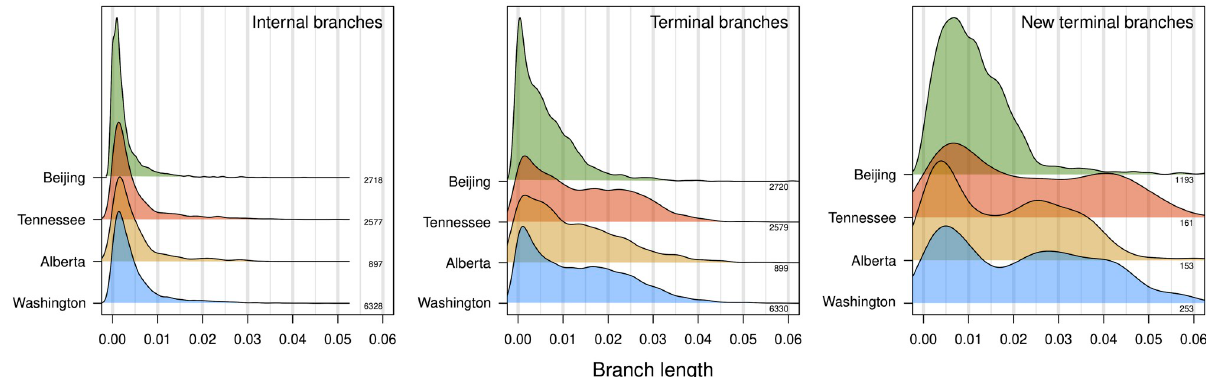
Fig 2. Distributions of branch lengths in HIV-1 pol phylogenies. Each density summarizes the distribution of branch lengths (measured in units of expected nucleotide substitutions per site) for different locations and types of branches, as indicated in the upper right corner of each plot. We used Gaussian kernel densities with default bandwidths adjusted by factors 1.5, 0.75 and 0.75, respectively. Densities are labeled on the right with the corresponding number of branches. Internal and terminal branches are derived from the phylogeny reconstructed from background sequences. New terminal branches refer to additional branches to incident (new) sequences as placed onto the phylogeny by maximum likelihood (pplacer).